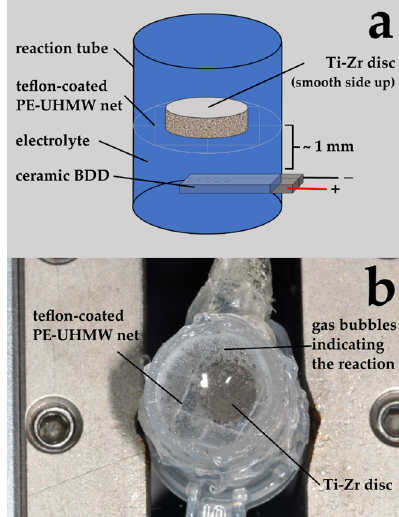
Figure 4. Experimental setup for electrochemical disinfection. ( a ) Schematic presentation, ( b ) situation during disinfection process with Ti-Zr disc resting on PE-UHMW net. Please note the gas bubbles indicating the electrochemical reaction.